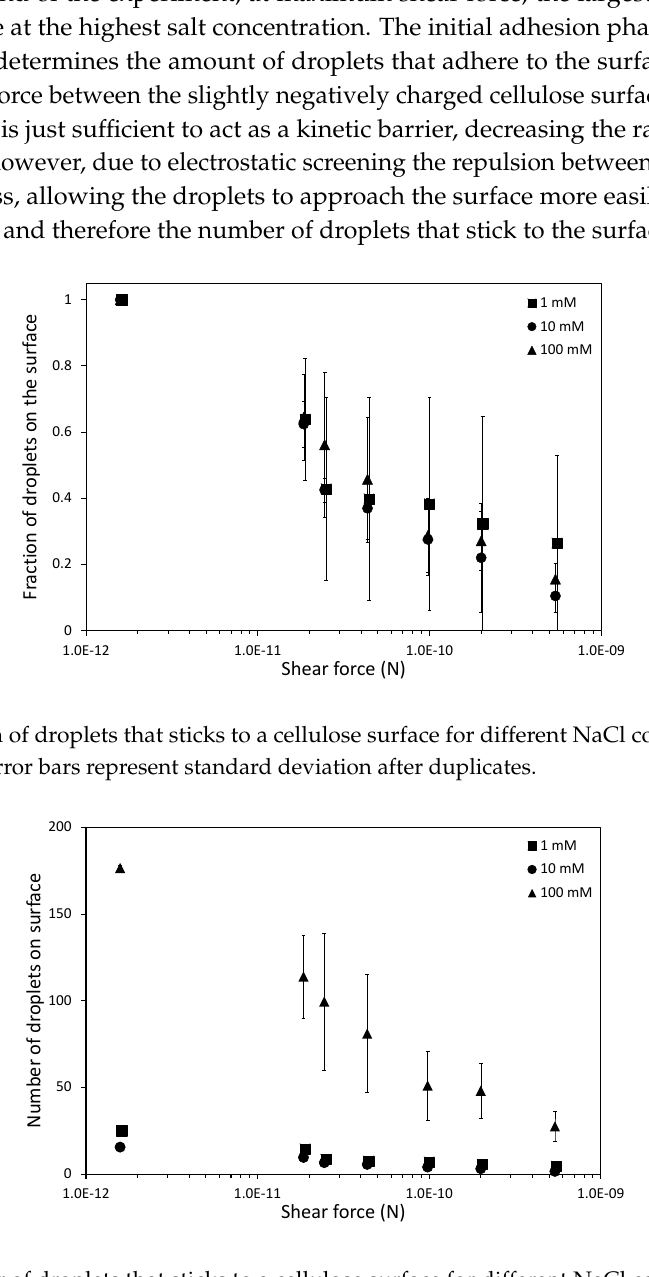
Figure 7. Number of droplets that sticks to a cellulose surface for different NaCl concentrations and 463 mg/L SDS. Error bars represent standard deviation after